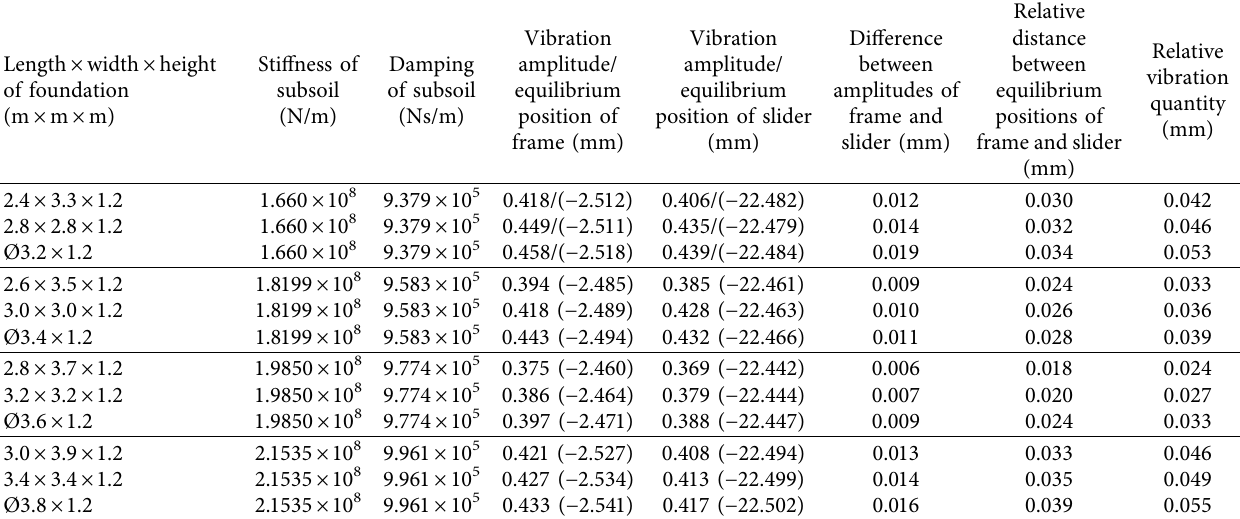
Length × width × height of foundation